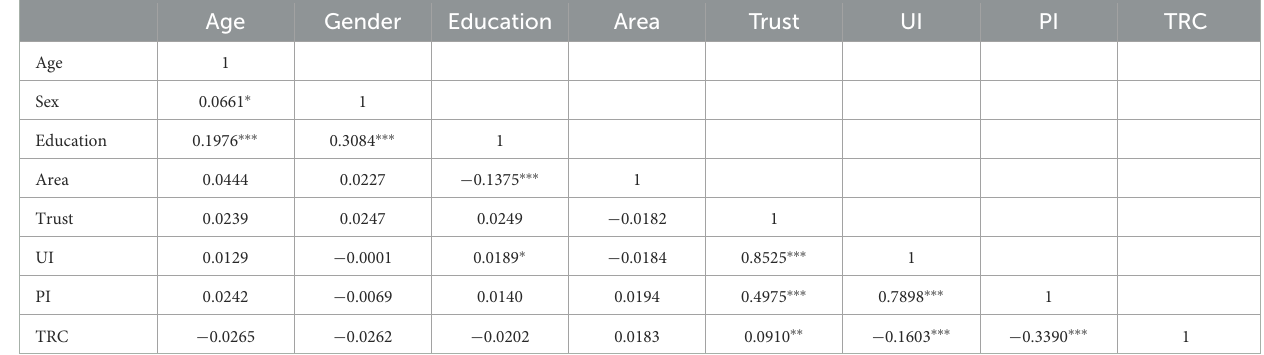
TABLE 4 Results of Pearson correlation coefficients.